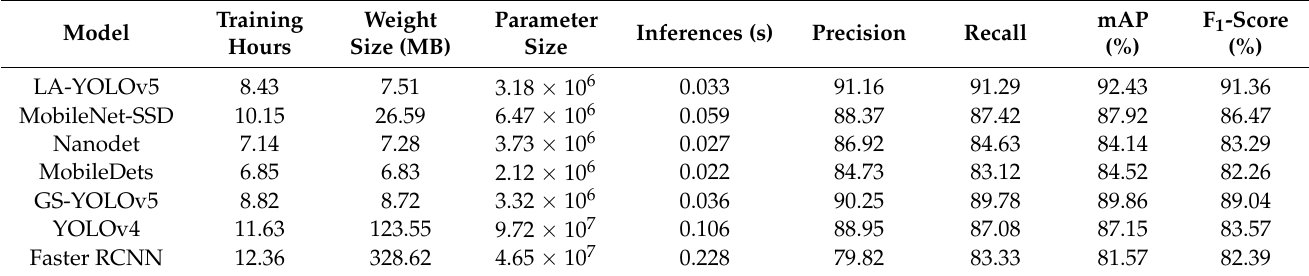
Table 4. Comparison of building damage detection using different